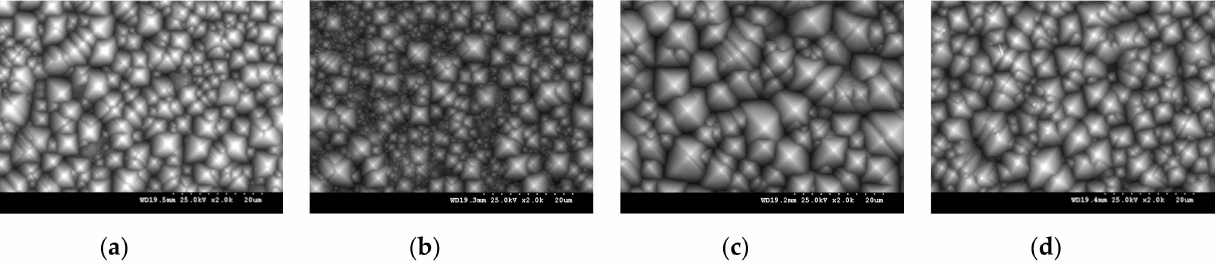
Figure 4. SEM images of wafer surface according to KOH and IPA concentrations: ( a ) KOH 2 wt.%, IPA 7.5 vol.%; ( b ) KOH 2 wt.%, IPA 9 vol.%; ( c ) KOH 3 wt.%, IPA 7.5 vol.%; and ( d ) KOH 3 wt.%, IPA 9